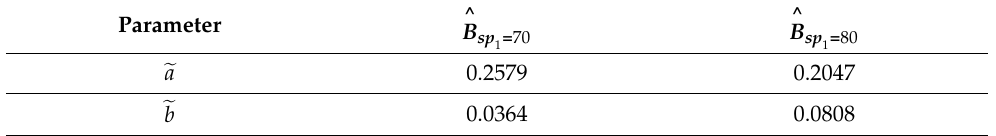
parameters’ values (procedure 1